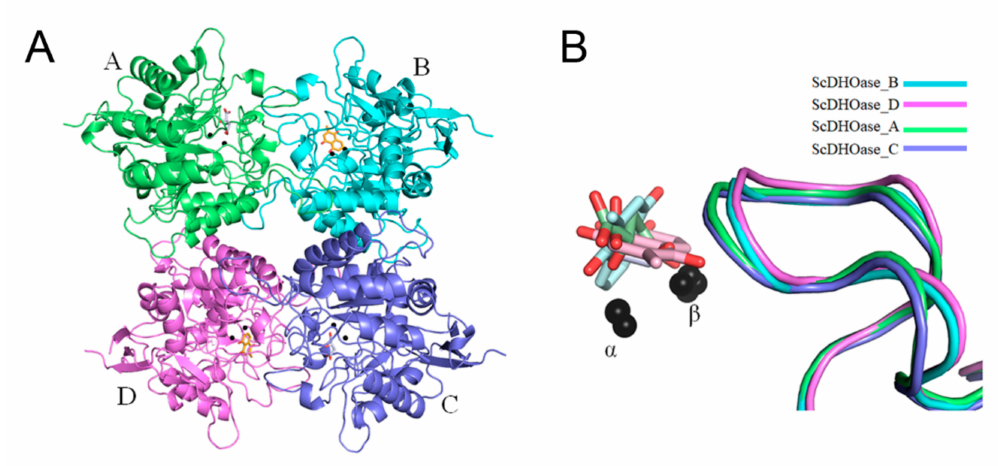
Figure 4. Structure of ScDHOase complexed with PLU. ( A ) Ribbon diagram of the PLU–ScDHOase complex tetramer. Each monomer is color-coded. Two zinc ions in the active site are presented as black spheres. PLU (bright orange) was found in the active site only in subunits B and D. Malate (slate) was occupied in subunits A and C. ( B ) Structural comparison of the active sites. The loops (amino acid residues 99–115) in different monomers of ScDHOase are color-coded. The superimposed structures of the PLU-bound states and the malate-bound states revealed that the flexible loop is in similar loop-in